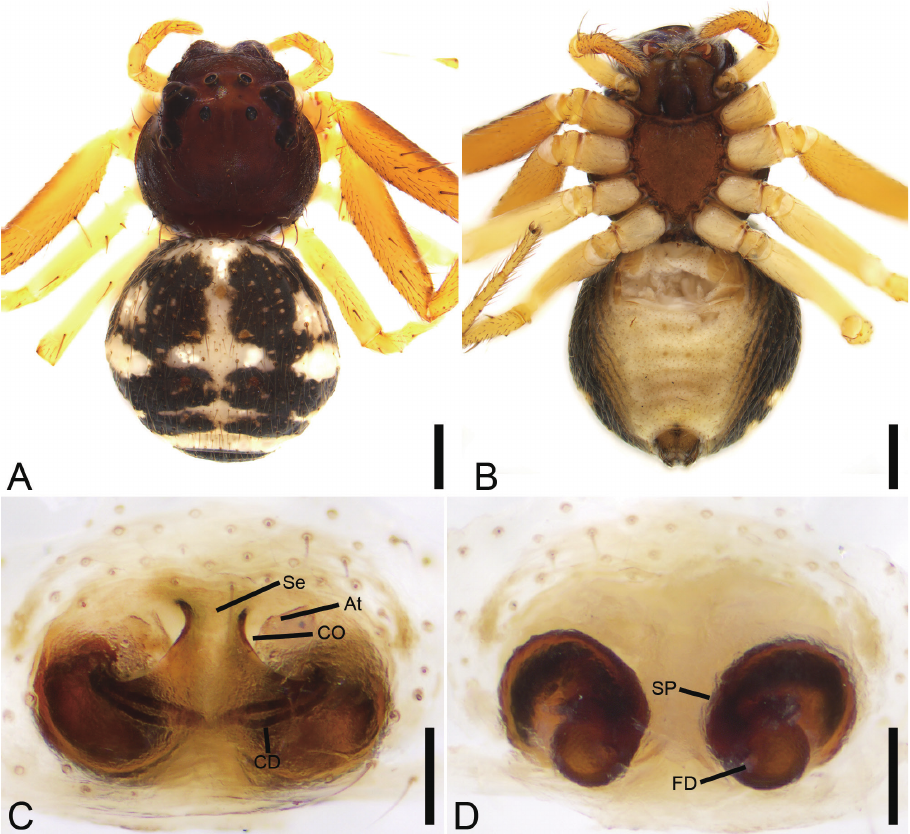
Figure 7. Lysiteles subspirellus sp. nov., female. A habitus, dorsal view B same, ventral view C epi- gyne, ventral view D same, dorsal view. Abbreviations: At – atrium, CD – copulatory duct, CO – cop- ulatory opening, FD – fertilisation duct, Se –septum, SP – spermatheca. Scale bars: 0.5 mm ( A, B ), 0.1 mm ( C, D